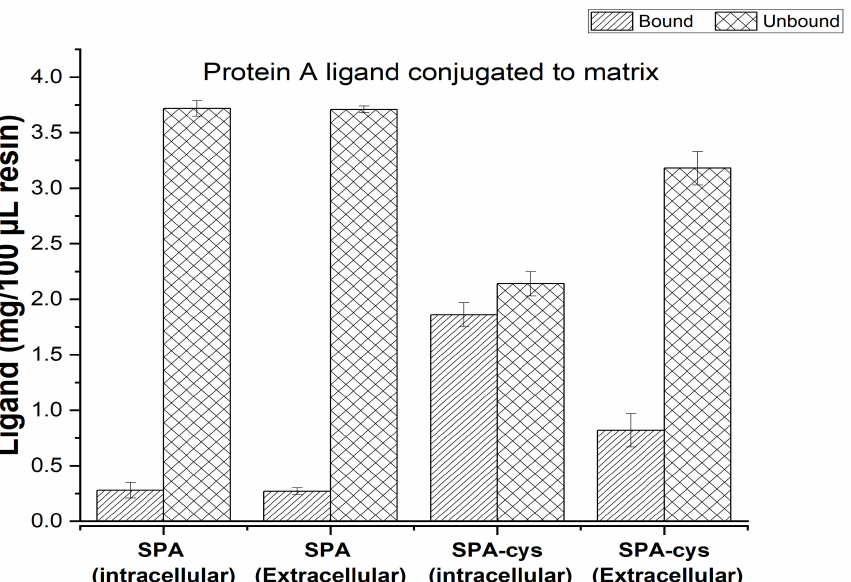
Figure 6. The bar graph showing binding of protein A ligand to solid support. The bound and unbound fraction of to 12.5 mg of resin when coupled with 4 mg of SPA (intracellular), SPA-cys (intracellular), SPA-cys